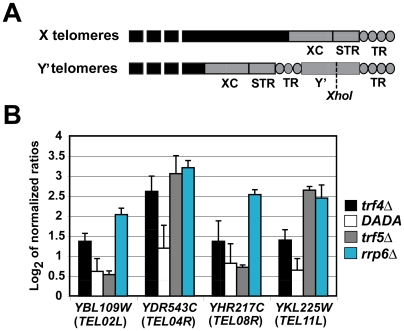
Subtelomeric transcripts are detected in strains defective in RNA surveillance pathways.(A) Schematic representation of yeast telomeres. X-type telomeres consist of the X element core sequences (XC), the subtelomeric repeats (STR), and the telomeric repeats at the ends of the chromosomes. The Y′-type telomeres contain a subtelomeric Y′ DNA sequence located within the telomeric repeats that is not found in X telomers. A conserved XhoI restriction site specific for Y′ sequences is shown. (B) Bar diagram representing the qRT–PCR analysis for four subtelomeric ORFs transcribed from X- and Y′-type telomeric regions. Corresponding telomeres are indicated in brackets. RNA amounts were normalized to ACT1 mRNA and are compared relative to the isogenic WT strain. Relative changes of transcript abundances (log2 ratio scale) represent averages from two independent qRT-PCR analyses. The same RNA preparation was used for the microarray analysis shown in Figure 1A.